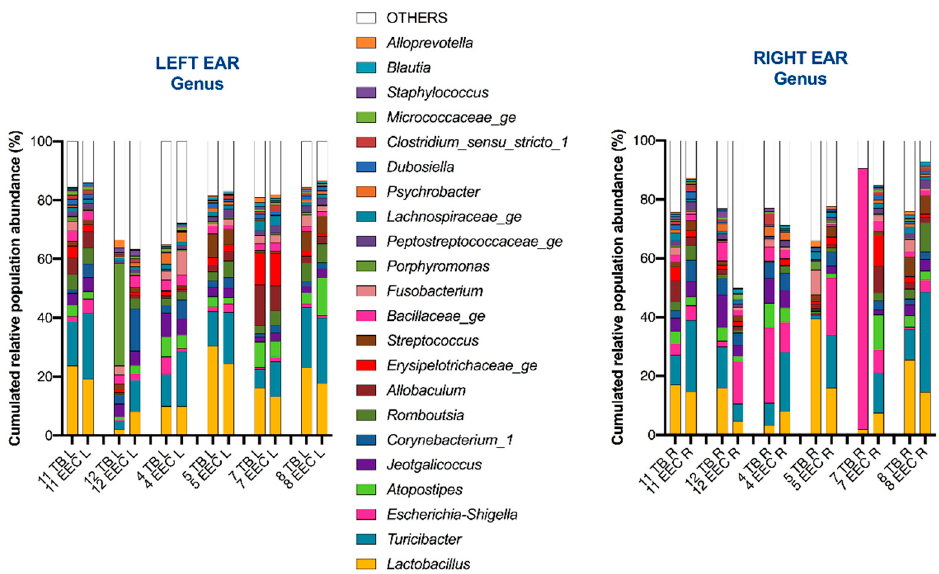
Figure 1. Composition of external ear canal and tympanic bulla microbiota in 12 ears from 6 healthy Beagle dogs. This bar chart shows the taxonomically annotated relative abundance of genera of all taxa detected in the left ear and right ear, collected from 6 healthy experimental Beagle dogs. Each column represents the tympanic bulla (TB) and external ear canal (EEC) microbiota of the left ear (L) or right ear (R) from healthy Beagle dogs (numbered 11, 12, 4, 5, 7 and